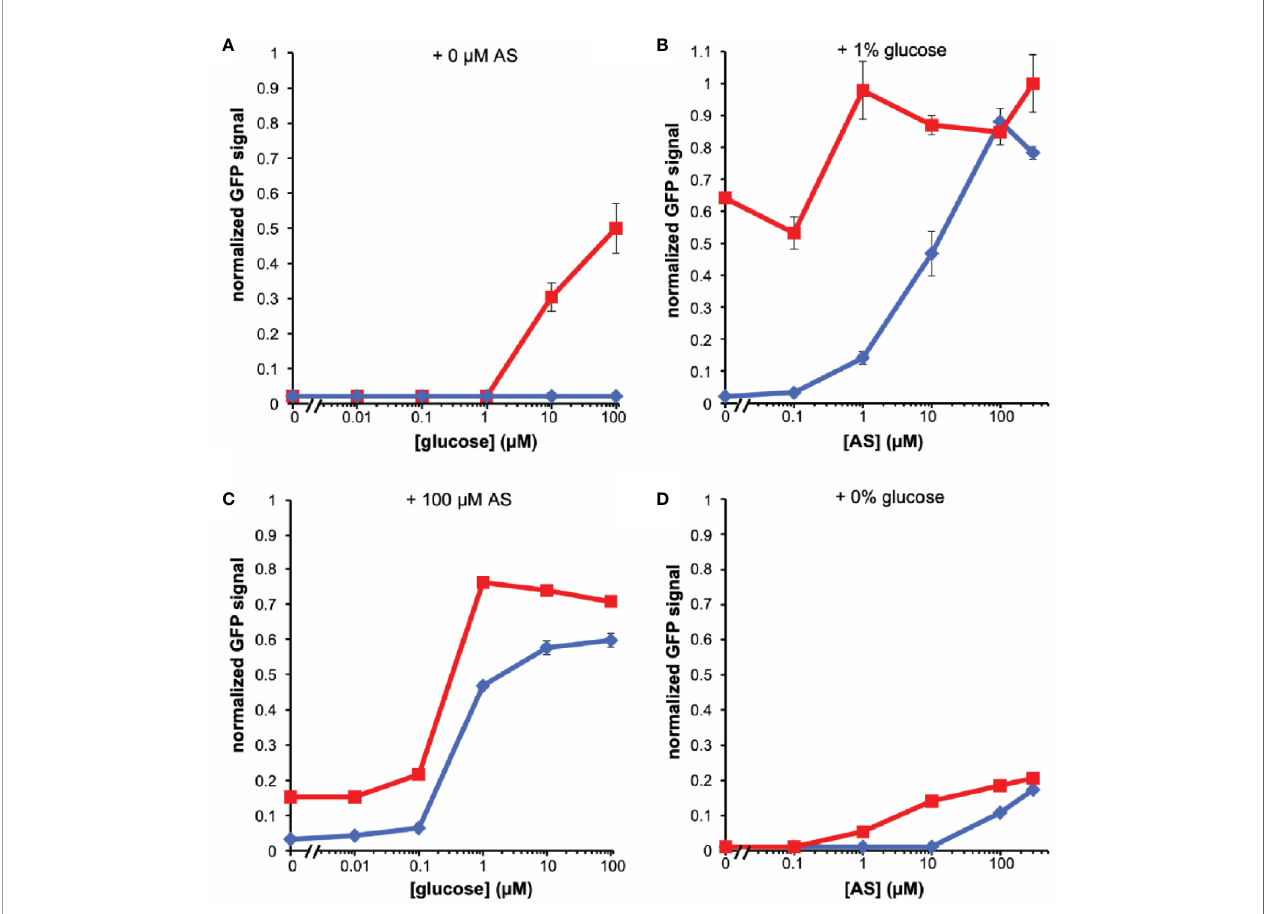
FIGURE 1 | Dose responses of A. tumefaciens fl uorescent strains to acetosyringone (AS) or glucose. Upon addition of AS or glucose, virE::gfp [AB650 wt (blue diamonds), YHL301 ss (red squares)] signal was measured and normalized to the maximal value of YHL301 ss GFP signal. Glucose dose responses with no AS (A) or 100 µM AS (C) in the growth medium and AS dose responses with 1% glucose (B) or 1% glycerol (D) in the growth medium. Glycerol is used as a non-inducing carbon source in the absence of glucose. Each data point represents the average of three biological replicates and error bars show ±